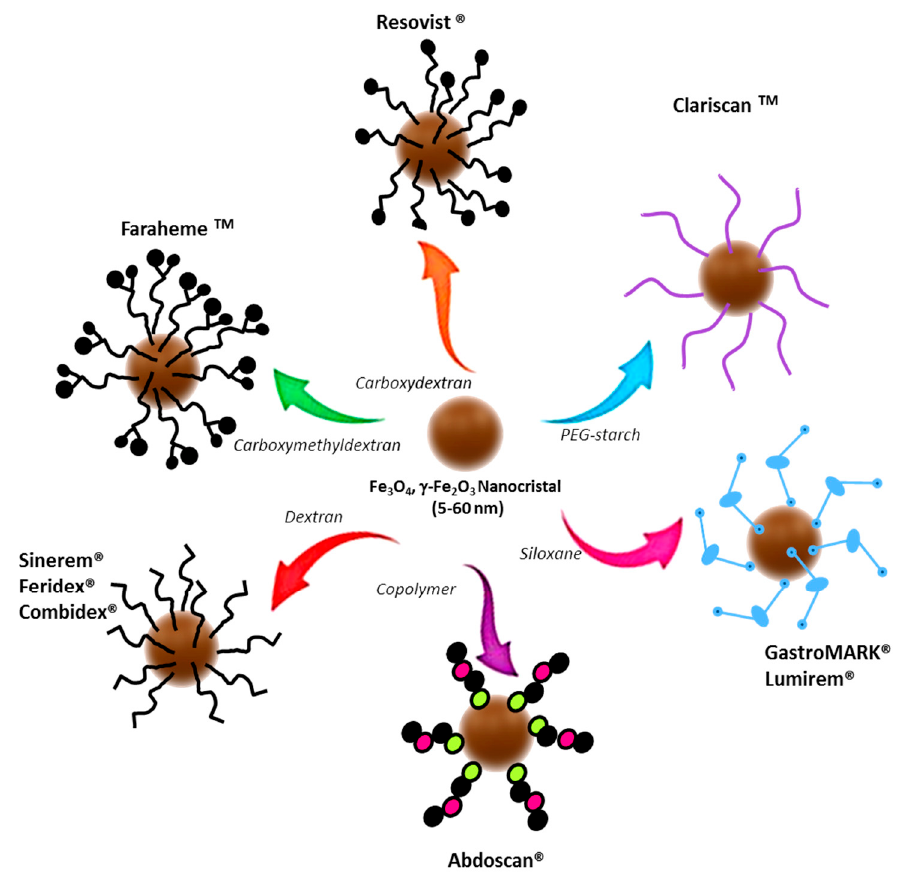
Figure 3. USPIOs clinically approved or in clinical trials.